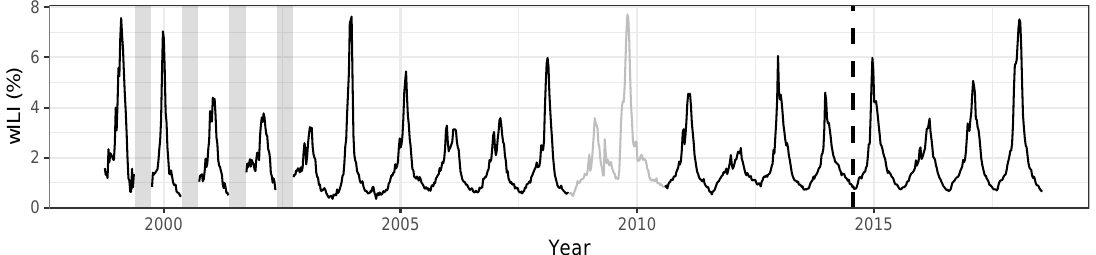
Figure 1. Weekly weighted influenza-like illness (wILI) index in the USA. In early years of data collection, low-season incidence was not recorded. These periods of missing data are indicated with vertical gray bars. The wILI index during the excluded pandemic seasons (2008/2009 and 2009/2010) is shown in gray. The last four seasons (2014/2015 to 2017/2018) after the vertical dashed line are held out as test